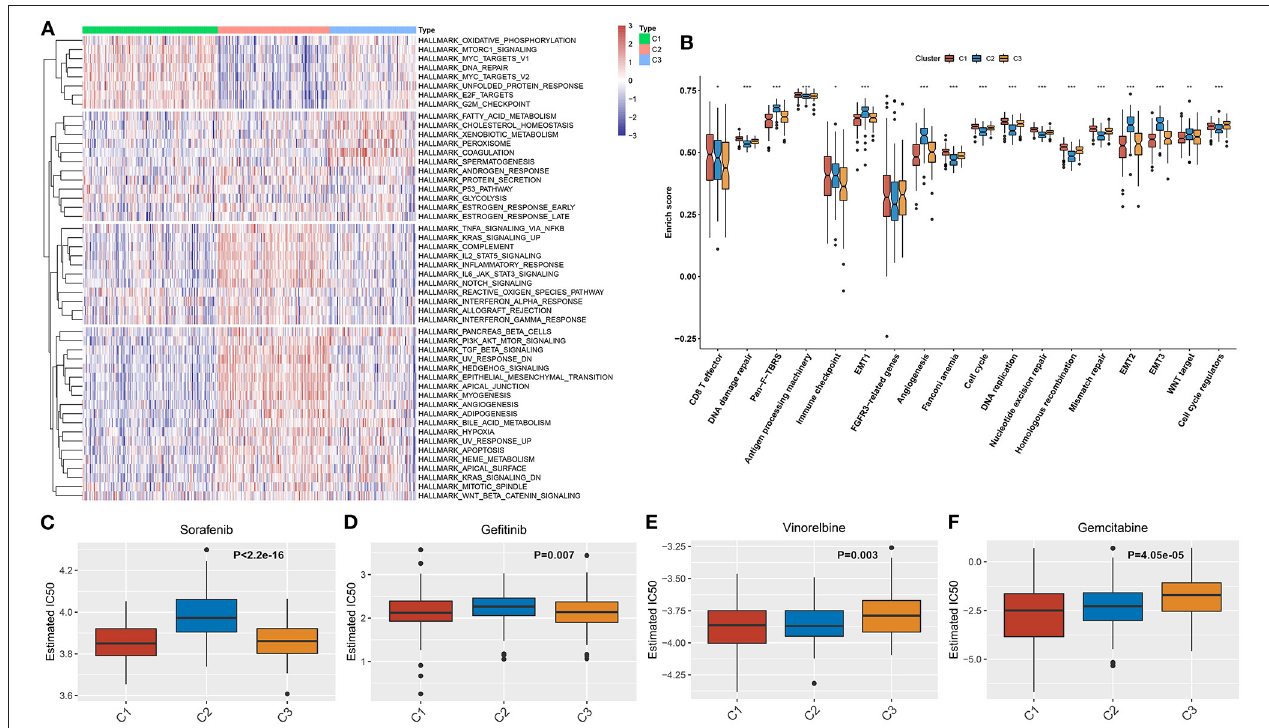
FIGURE 3 | Aging-associated molecular phenotypes with distinct activations of functional pathways and chemotherapeutic responses. (A) Heatmap visualized the activities of the 50 hallmark gene sets in three aging-associated molecular phenotypes. (B) Comparisons of the activities of common biological processes among distinct molecular phenotypes. (C–F) Comparisons of the estimated IC50 values of chemotherapeutic agents, including (C) sorafenib, (D) gefitinib, (E) vinorelbine, and (F) gemcitabine. * p < 0.05; ** p < 0.01; *** p < 0.001.